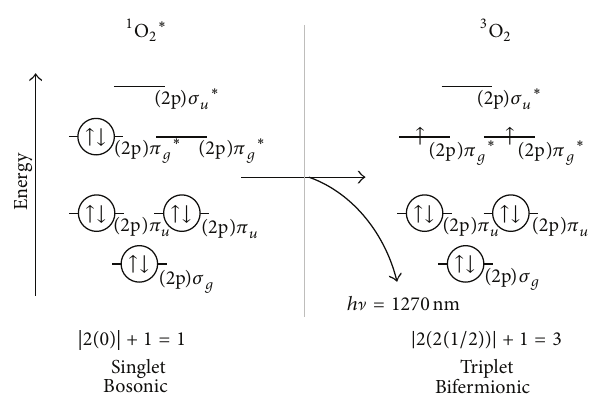
Figure 5: Relaxation of singlet molecular oxygen to its triplet ground state by infrared photon emission. For simplicity, only the (2p) 𝜎 , 𝜋 , 𝜋 ∗ , and 𝜎 ∗ orbitals of O 2 are shown.